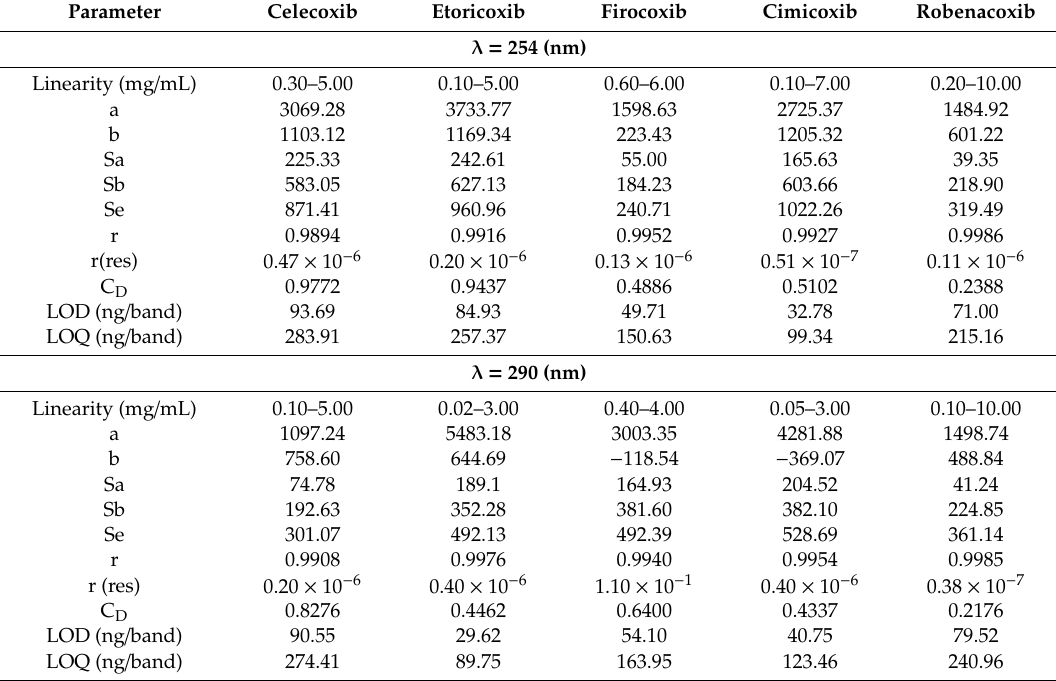
Table 2. Regression equations and validation parameters obtained for analyzed compounds. Parameter